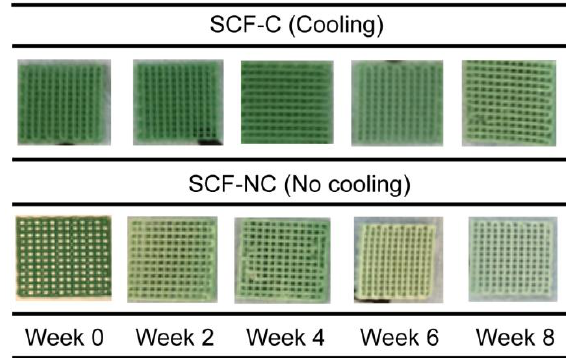
Figure 5. Photographs of samples after immersion. The color fading is a clue to the surface and erosion degradation induced by hydrolysis. The color fading is more evident in the SCF-NC specimens.